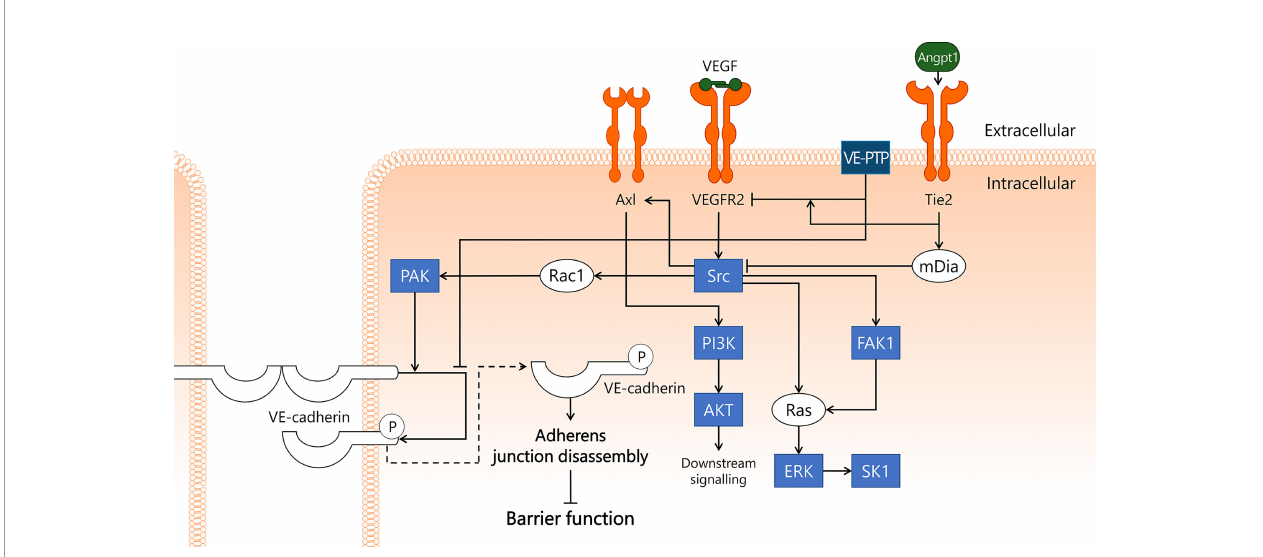
FIGURE 6 | VEGF/VEGFR2 pathway disrupts endothelial barrier function in sepsis. VEGFR2 is well-known for its role in angiogenesis, but it is also thought to play a key role in sepsis-induced endothelial barrier dysfunction. VEGF binds to VEGFR2, leading to activation of Src kinase. Src then binds to and activates FAK1, which induces activation of Ras/ERK/SK1 through both Src and FAK1. In addition, Src activates PI3K/AKT via Axl, and Rac1/PAK. PAK phosphorylates VE-cadherin, leading to its internalisation and subsequent disassembly of adherens junctions, which results in disrupted endothelial barrier function. This process is inhibited by VE-PTP, which closely associates with VE-cadherin, hereby preventing its phosphorylation. VE-PTP also dephosphorylates VEGFR2, a process that is promoted by the vicinity of Tie2. Tie2 activation induces activation of mDia, which sequesters Src and prevents its involvement in the VEGF/VEGFR2 pathway. AKT, protein kinase B; Angpt1, angiopoietin-1; Axl, Axl receptor tyrosine kinase; ERK, extracellular signal-regulated kinase; FAK1, focal adhesion kinase 1; mDia, mammalian Diaphanous-related formin Dia; PAK, p21-activated kinase; PI3K, phosphoinositide 3-kinase; Rac1, Ras-related C3 botulinum toxin substrate 1; Ras, Ras protein subfamily; SK1, sphingosine kinase 1; Src, Src protein tyrosine kinase; Tie2, tunica intima endothelial kinase 2; VEGF, vascular endothelial growth factor; VEGFR2, vascular endothelial growth factor receptor 2; VE-cadherin, vascular endothelial cadherin; VE-PTP, vascular endothelial protein tyrosine